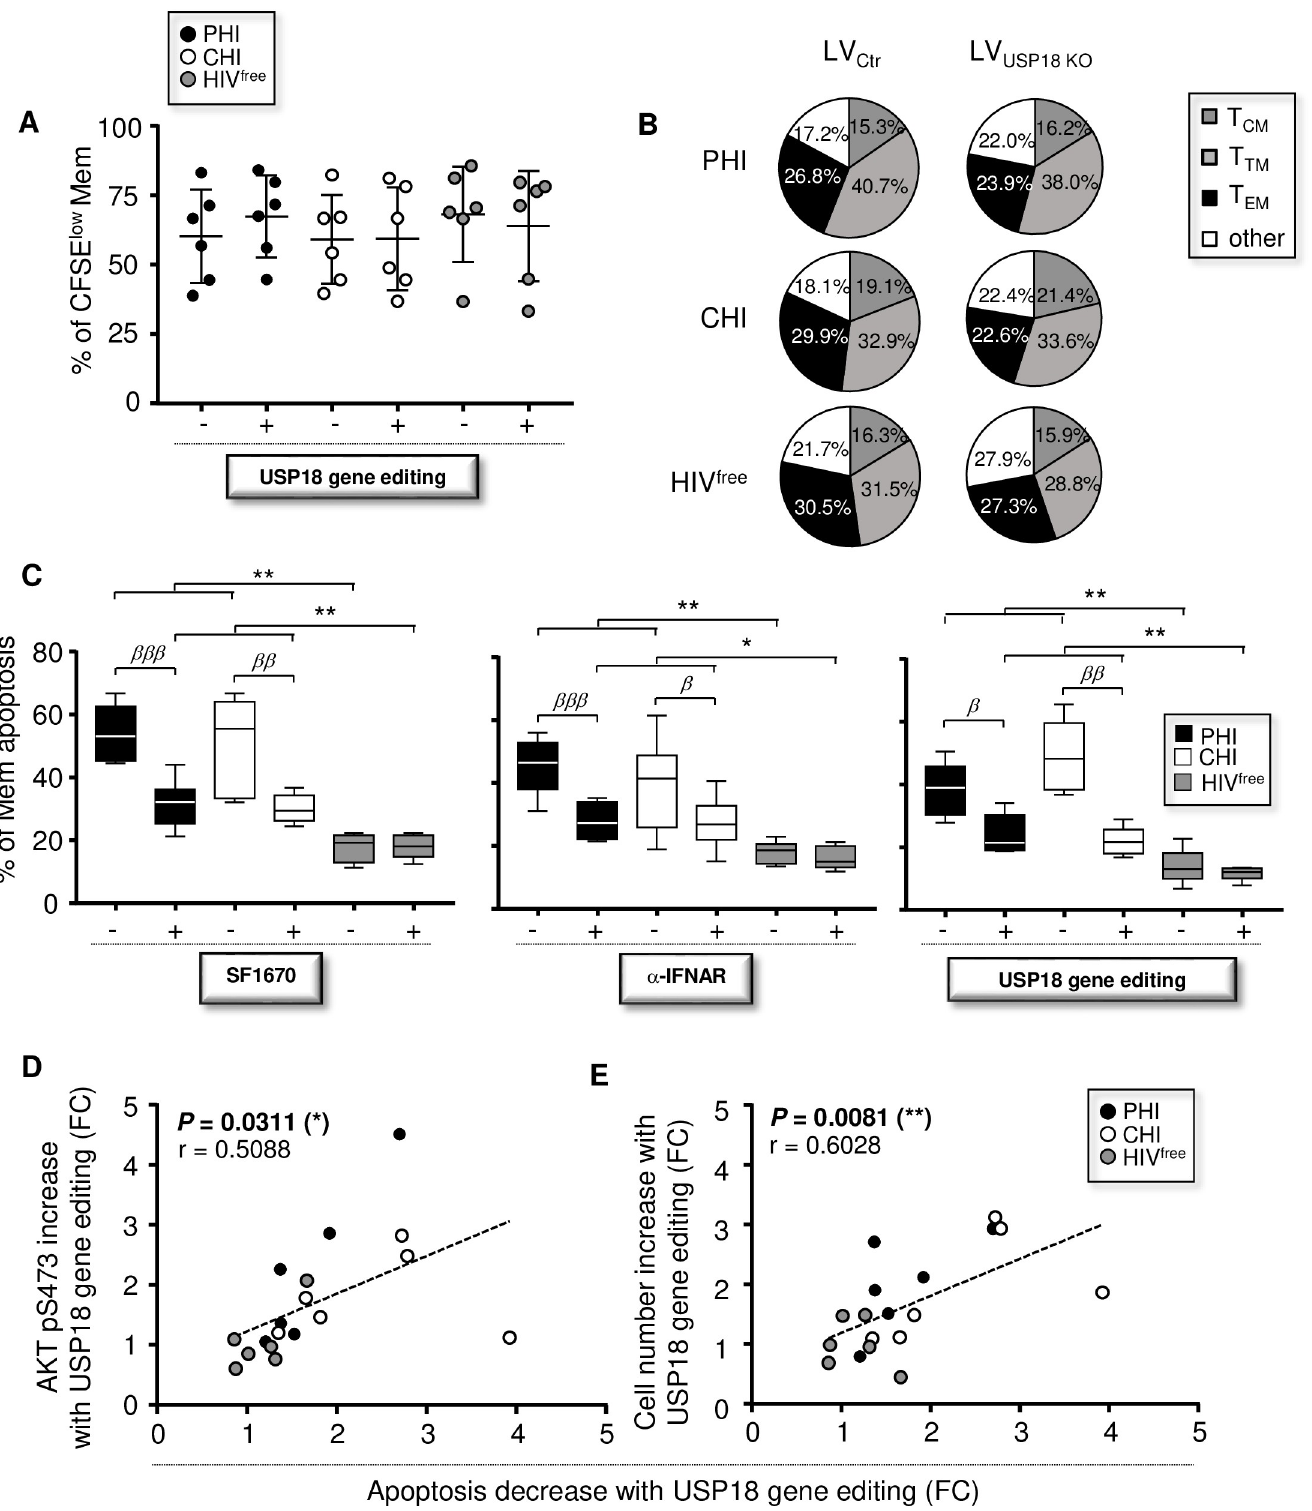
Fig 6. Improvements of Mem maintenance in PHI and CHI with USP18 gene editing are associated with lower cell death. ( A ) Levels of proliferation determined at day 7 of culture by the percentages of viable CFSE low Mem with or without CRISPR/Cas9 mediated USP18 gene editing (n = 6). ( B ) Distribution of Mem subsets at day 7 of culture with or without CRISPR/Cas9 mediated USP18 gene editing (n = 6). ( C ) Percentages of apoptotic Mem on day 7 with or without SF1670 (left), α -